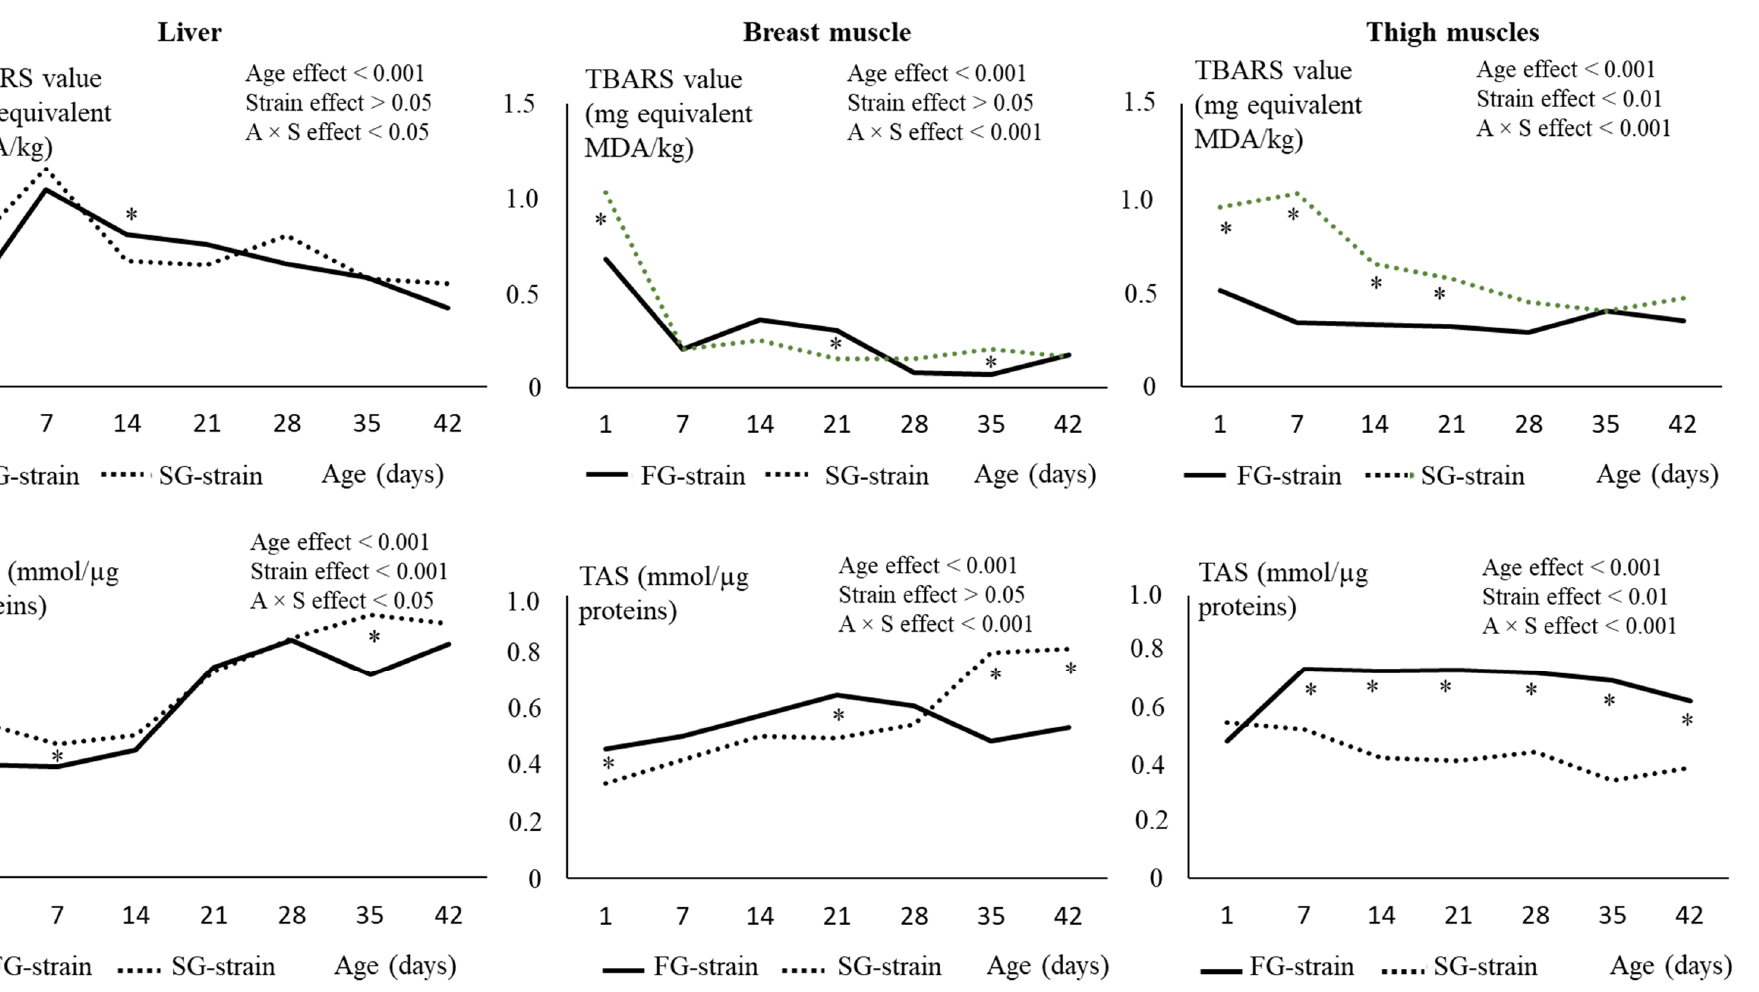
Figure 4. Effects of age (A) and strain (S) and their interaction on thio-barbituric reactive substance (TBARS) content and total antioxidant status (TAS) in the liver, breast and thigh muscles. Data are presented as the means; n = 10 per strain and per age. *: Significant difference ( p < 0.05) between strains for a given age; FG = fast-growing, SG = slow-growing.